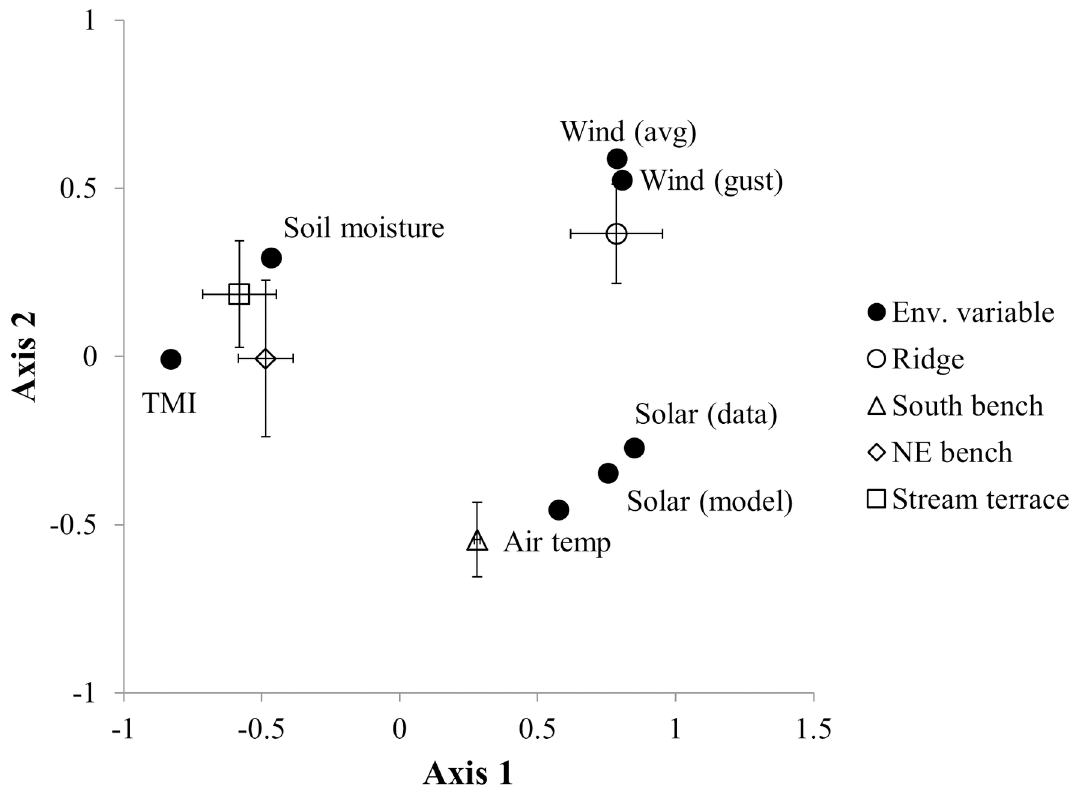
Fig 3. Factor analysis of modeled and measured environmental conditions at common garden locations. Included are factor scores for modeled and measured solar radiation, modeled soil moisture index, measured soil moisture, measured air temperature, and measured average wind and maximum gust speeds. Factor 1 explains 64% of the variation and 16% is explained by Factor 2. The average score and standard errors for each topographic position from N = 4 sites (Fig 2) are included in the plot. The standard error for south benches along axis 1 are small and not visible.